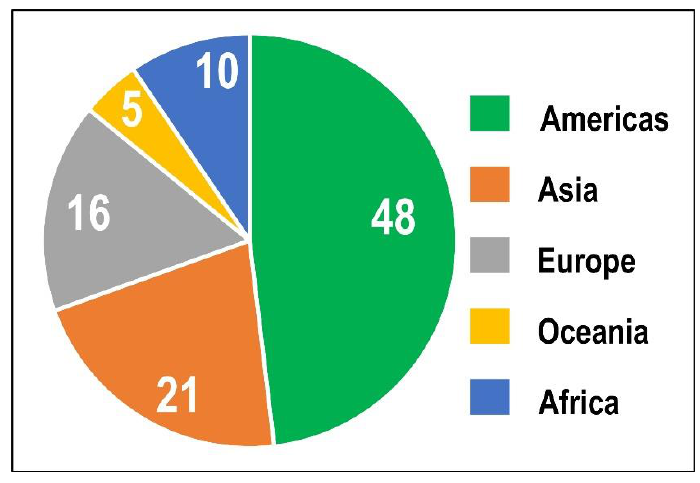
Figure 2. Average cattle meat production by region from 2009 to 2019 [66].